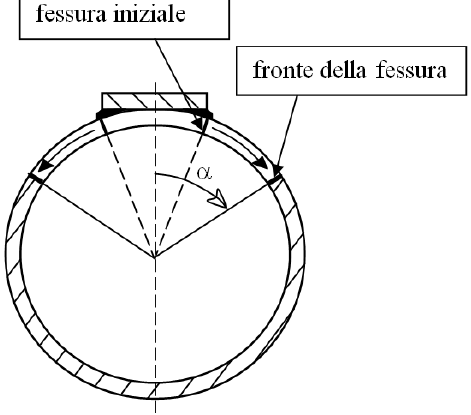
Figura 3: Modello di avanzamento del